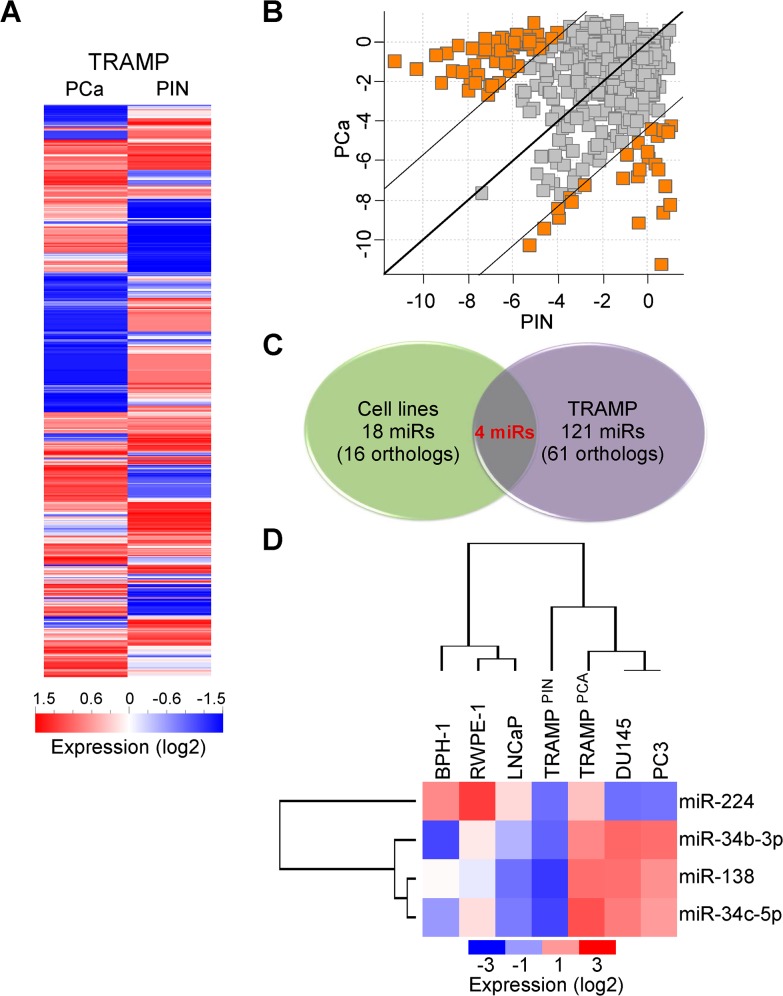
miRNA expression in TRAMP-derived tissues.
A) Global miRNA profiling of prostate cancer (PCa) or prostatic intraepithelial neoplasia (PIN) lesions isolated from TRAMP mice. B) Scatterplot diagram of miRNAs with differential expression of at least 20 folds between PIN and PCa tissues of TRAMP mice. Of the identified 121 deregulated miRNAs (S1 Table) 61 had human orthologs. C, D) Comparison of significant miRNA signatures between prostate cell lines and TRAMP lesions. Only four miRNAs were in common between the two experimental systems. Expression analysis followed by unsupervised hierarchical clustering D) of miR-224, -34b-3p, -138 and miR-34c-5p reveals that androgen-independent prostate cancer cells are more similar to TRAMP tissues than to androgen-dependent or non-tumorigenic prostate human cells.